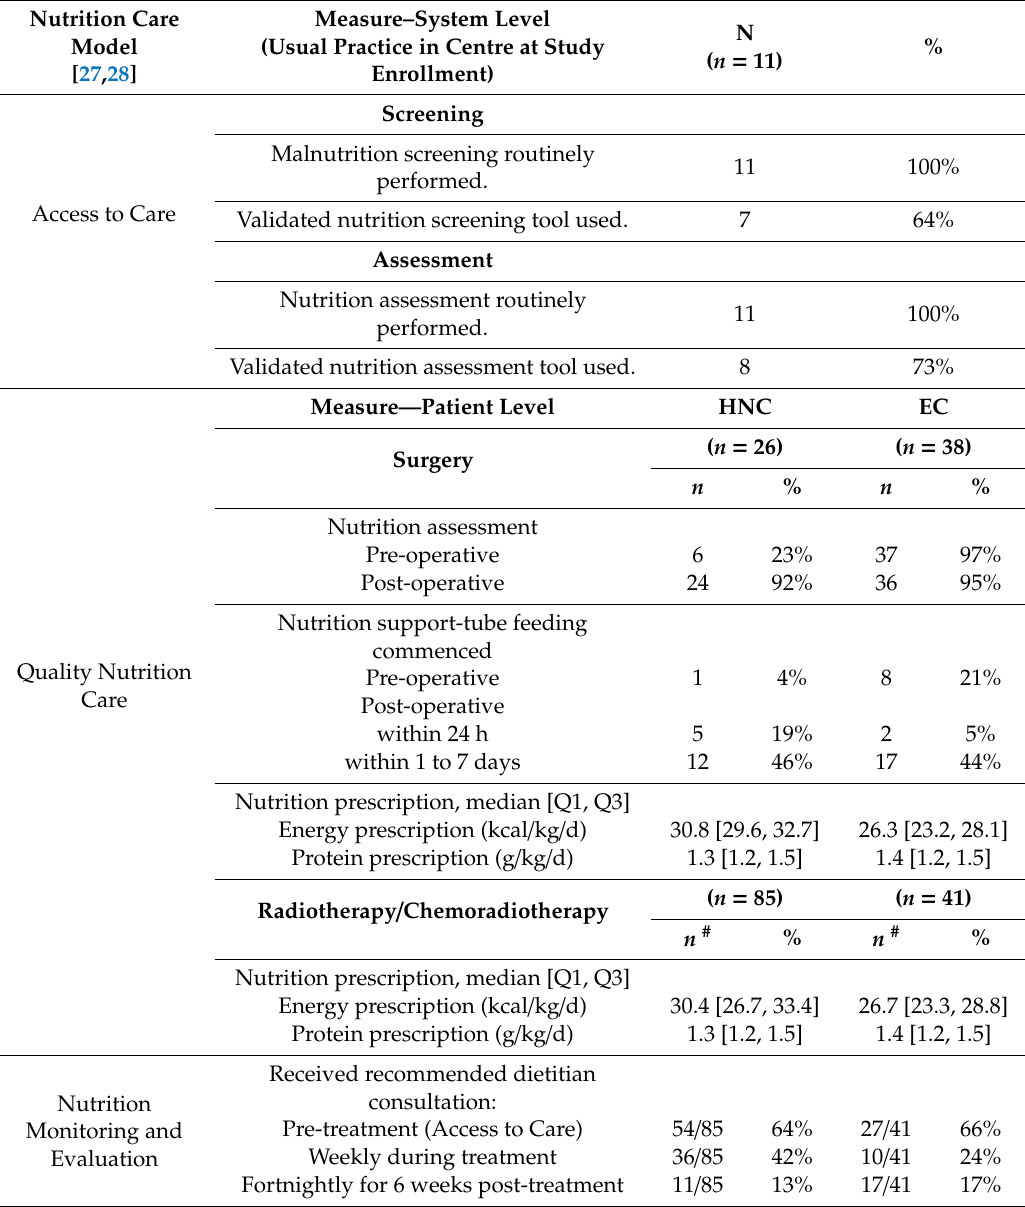
Table 5. Adherence to evidence-based guideline recommendations. Access to care (screening and assessment) by the total number of participating sites ( n = 11); quality nutrition care and nutrition monitoring and evaluation by the total number of patients ( n =